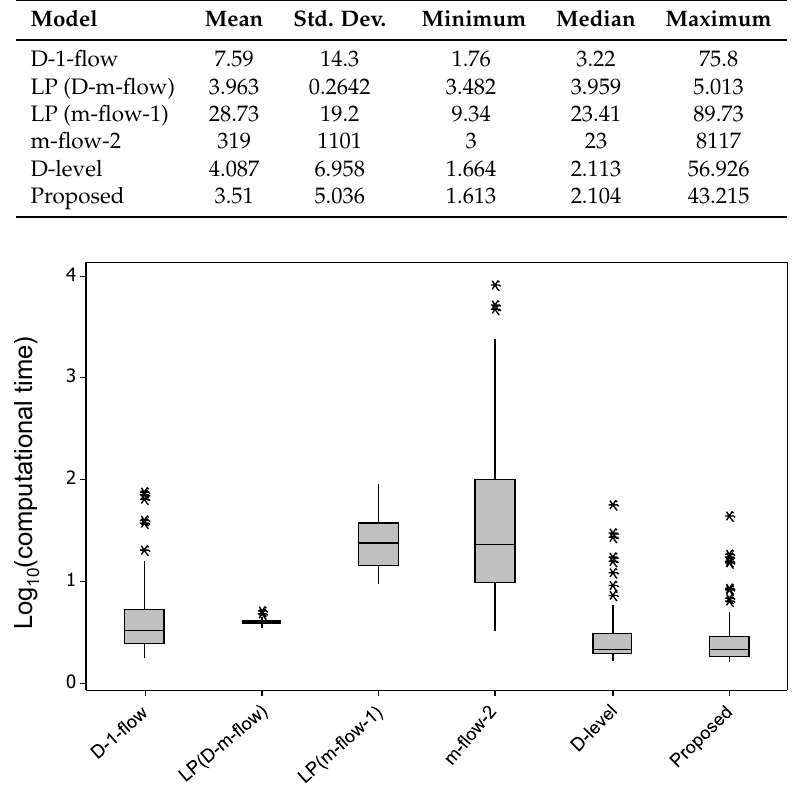
Figure 4. Box and Whisker plots for the distribution of computational times in seconds of selected models for the 30-node instances.